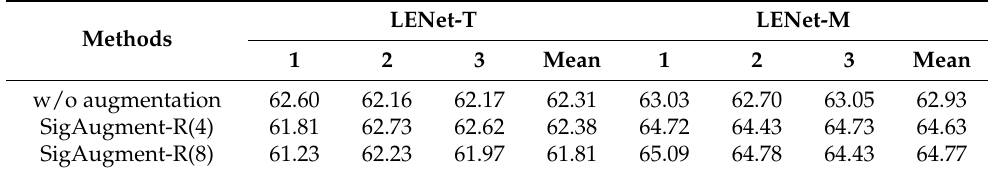
Table 14. Impact of the number of transformations in the transformation pool on model performance. LENet-T LENet-M Methods